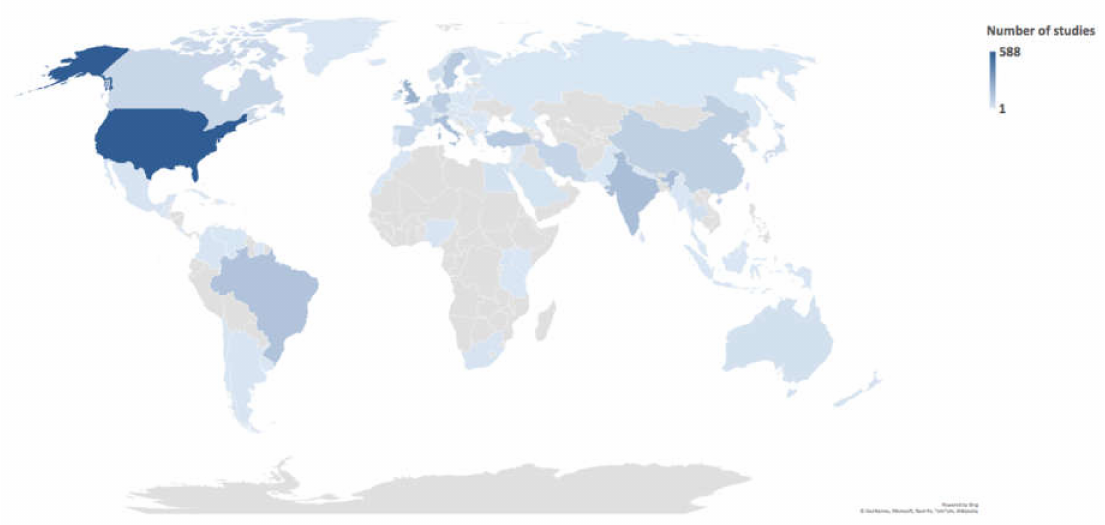
Figure 2. World map for the distribution of conducting